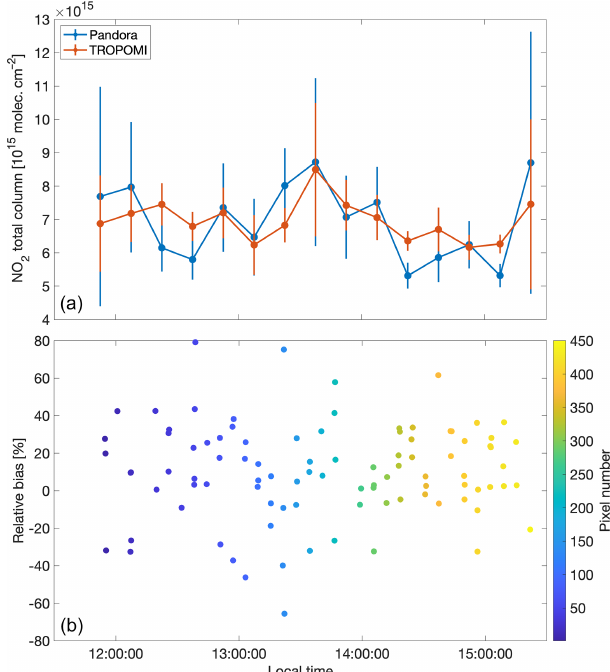
Figure 5. (a) TROPOMI NO 2 summed columns and Pandora to- tal columns as a function of the time of day between about 12:00 and 15:00LT. The error bars are the standard errors of the mean. (b) Relative difference between TROPOMI summed columns and Pandora total columns as a function of the time of day. The colours of the circles correspond to the TROPOMI pixel